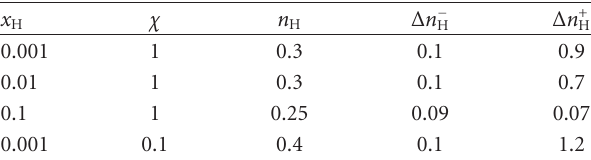
Table 2: Statistics for n H marginalized over T corresponding to the results of Figure